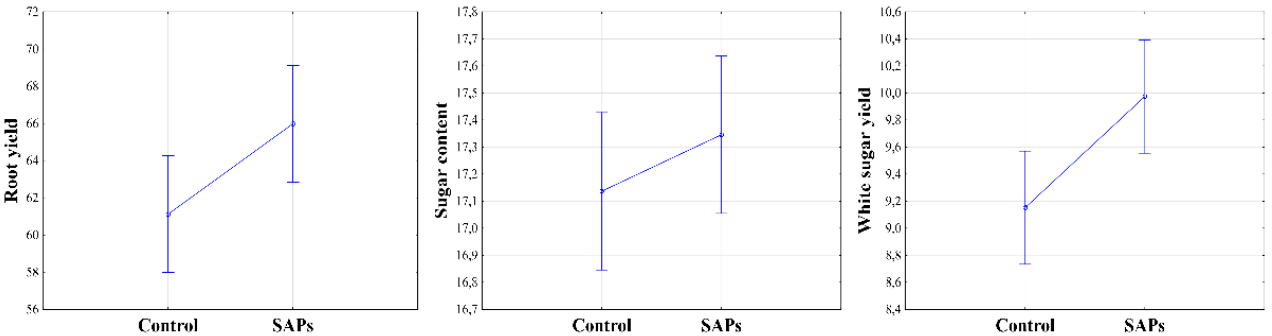
Figure 8. Root yield (t ha − 1 ), sugar content (%) and white sugar yield (t ha − 1 ) depending on experimental treatments. Figures with RY and WSY were obtained at level of significance α = 0.01, figure with SC was obtained at level of significance α = 0.05.